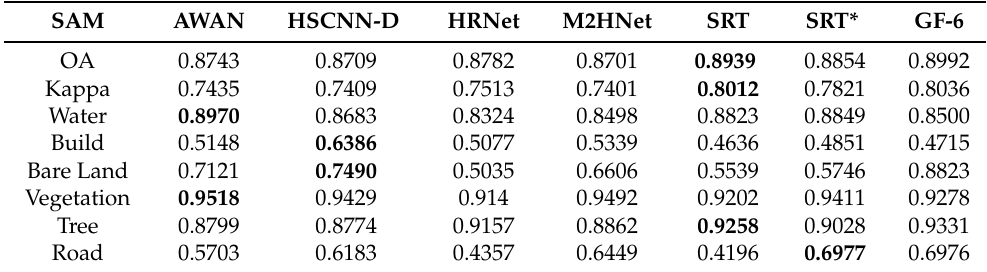
Table 6. Accuracy of classification result of Area1 with SAM. The best results are shown in